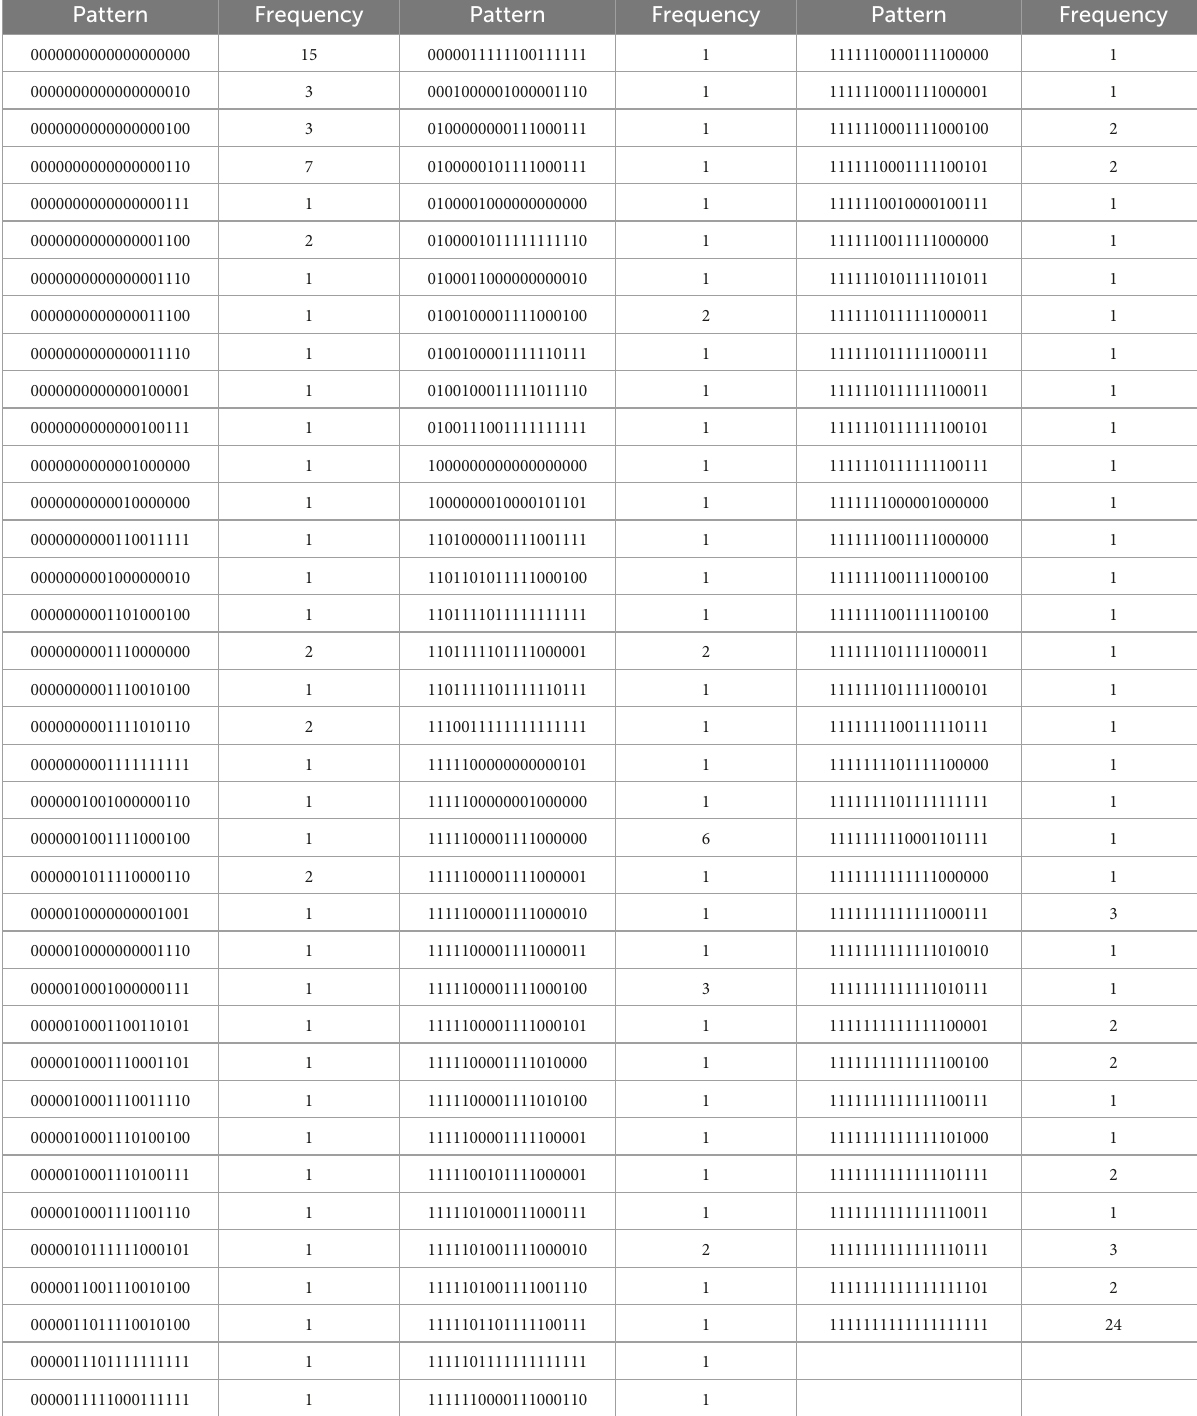
TABLE 4G All regulations, with N = 180, k = 19 items, and u = 109 unique response patterns ( Appendix B